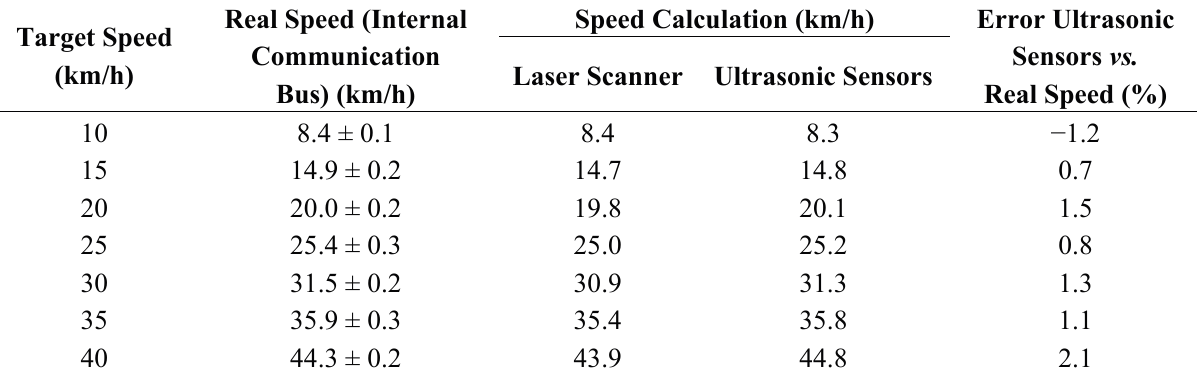
Table 2. Comparison between estimated and measured speeds (average values of five repetitions at each target